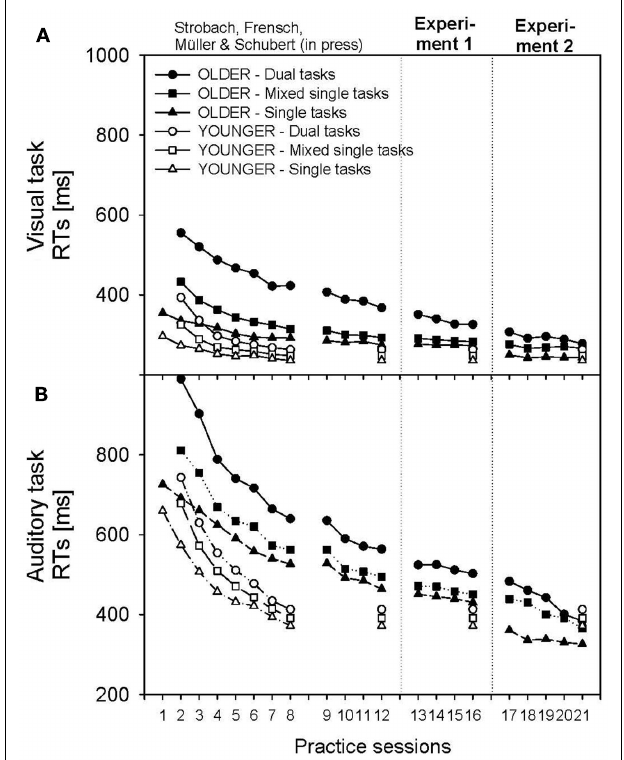
FIGURE 1 | Mean reaction times (RTs) in milliseconds (ms) on single-task trials in single-task blocks, single-task trials in mixed blocks (mixed single-task trials), and dual-task trials for (A) the visual task and (B) the auditory task across Sessions 2–21 (older adults) or Sessions 2–8 (younger adults). Session 2–12: Strobach et al. (2012b), Session 13–16: Experiment 1, Session 17–21: Experiment